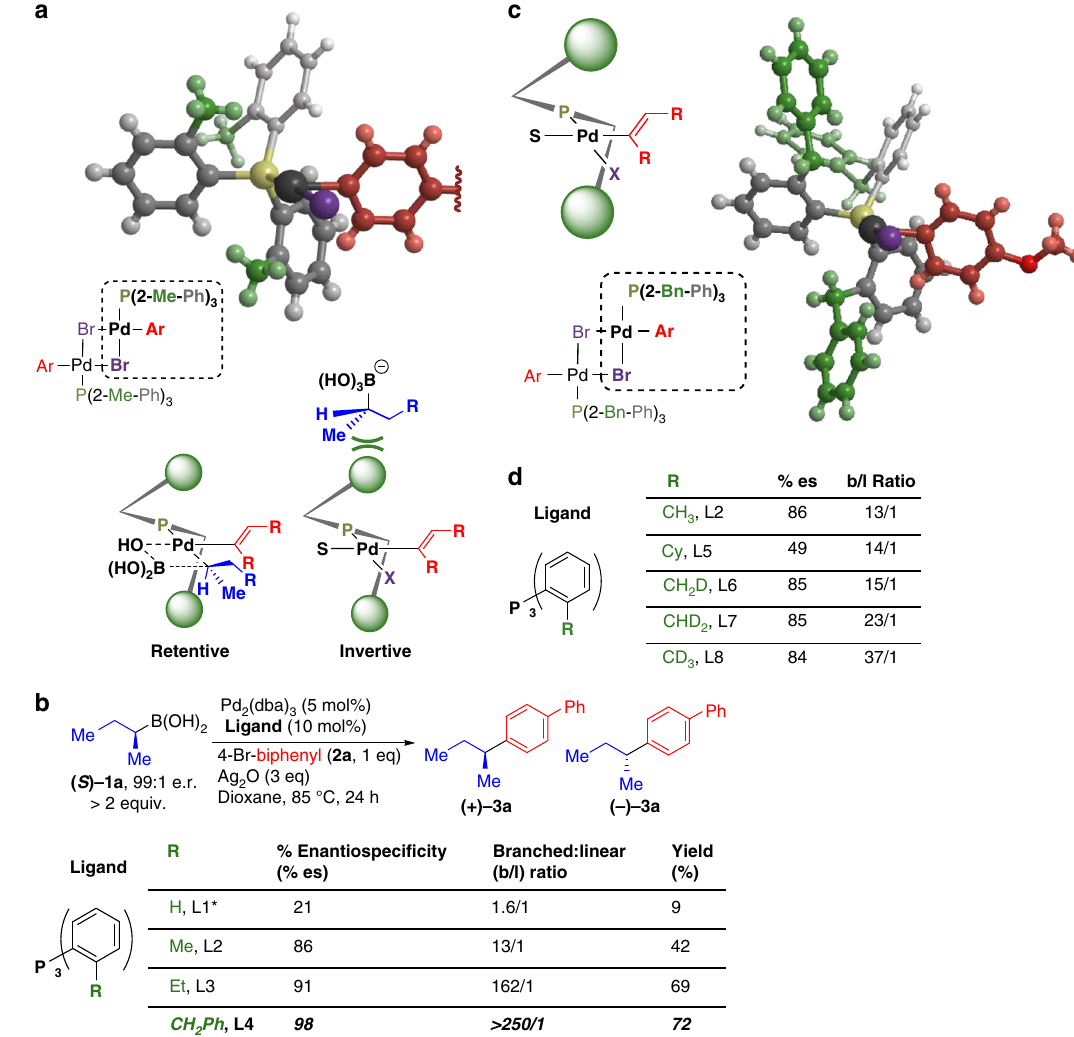
Fig. 2 Tuning of ligand sterics. a Crystal structure of {[(2-Me-Ph) 3 P]Pd(4- n Bu-Ph)(Br)} 2 and concept of blocking of the axial sites on Pd. b Model coupling reaction for optimizing ligands ( ortho -substituent optimization) Pd(PPh 3 ) 4 was used due to insuf fi cient yield with Pd 2 dba 3 /PPh 3 . c Crystal structure of {[(2- Bn-Ph) 3 P]Pd(4-OMe-Ph)(Br)} 2 is consistent with the axial shielding ligand design principle. d % es and b / l ratio do not necessarily correlate as a